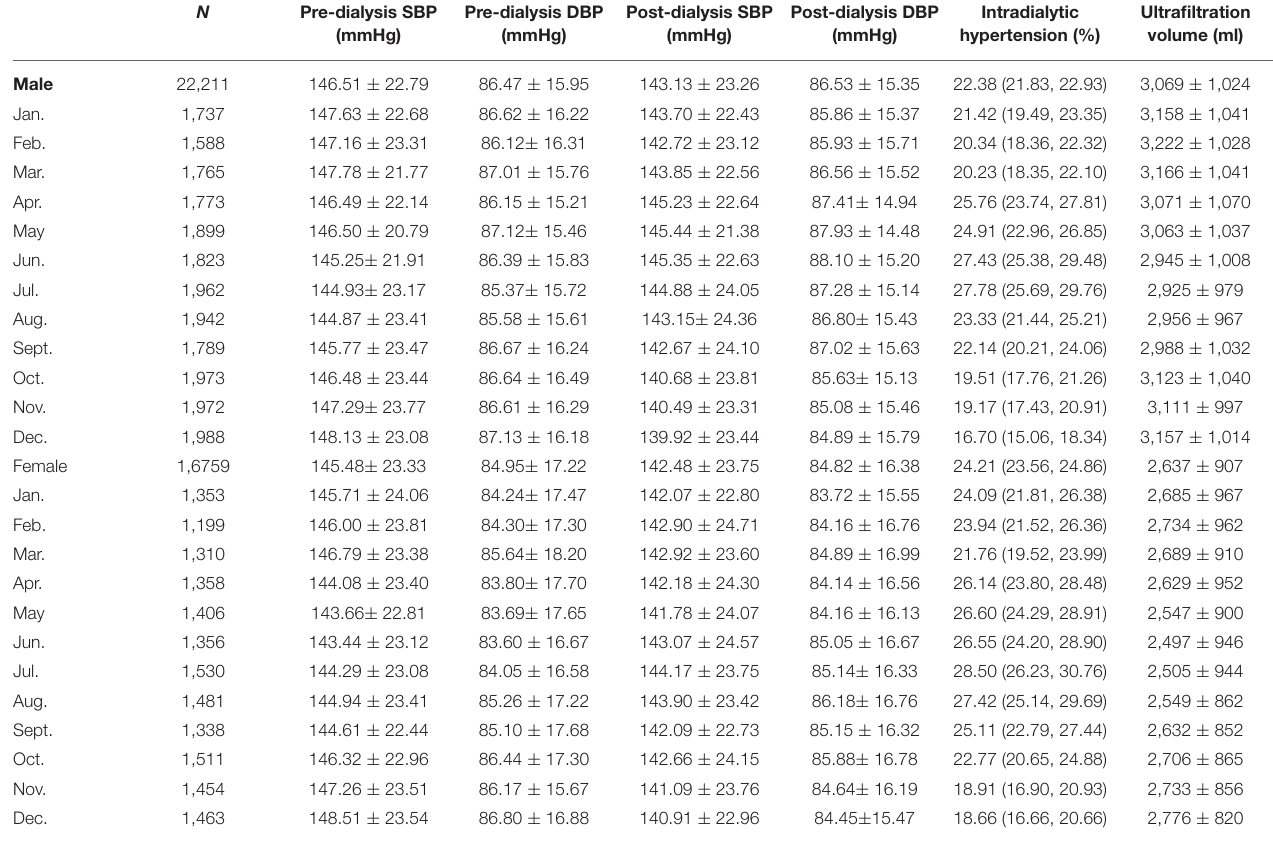
TABLE 2 | Pre-dialysis BP, post-dialysis BP, intradialytic hypertension, and HD UV in men and women.